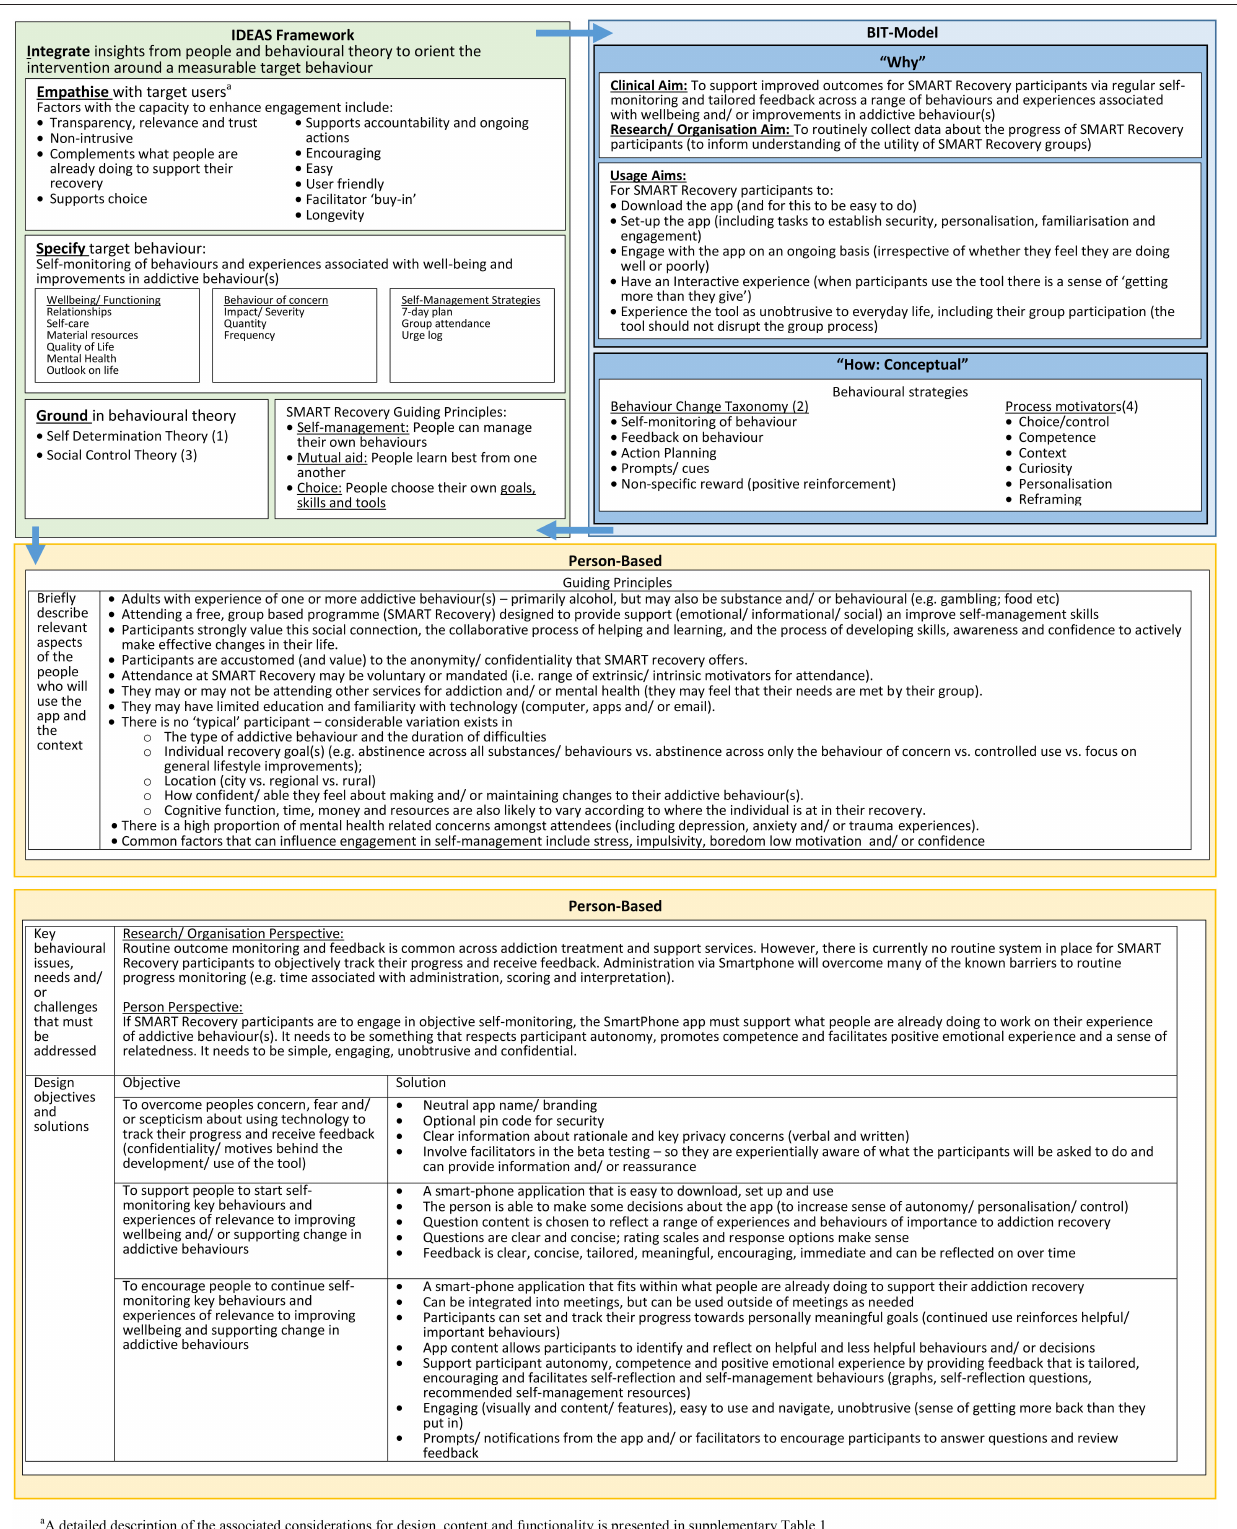
FIGURE 2 | Stage one findings used to inform app development, as a function of theoretical model.